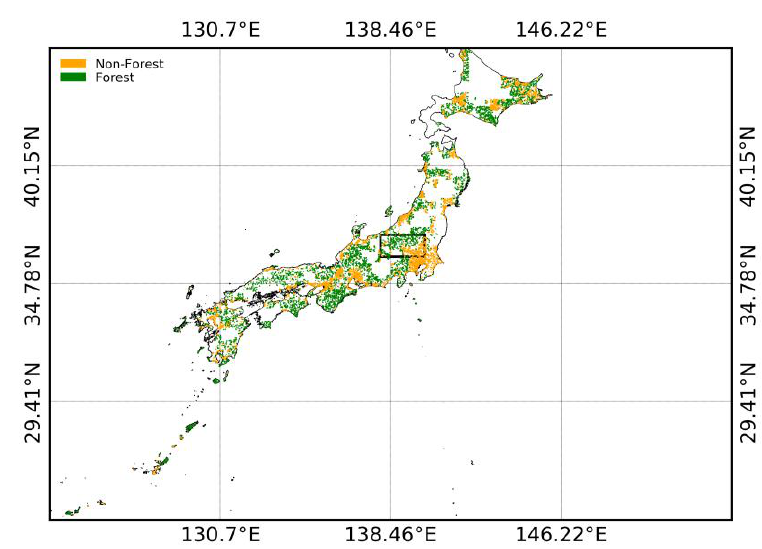
Figure 1. Distribution of reference points used in the research over the national territory. The national boundary is based on the Global Administrative Areas database (GADM) version 3.6, May 2018.